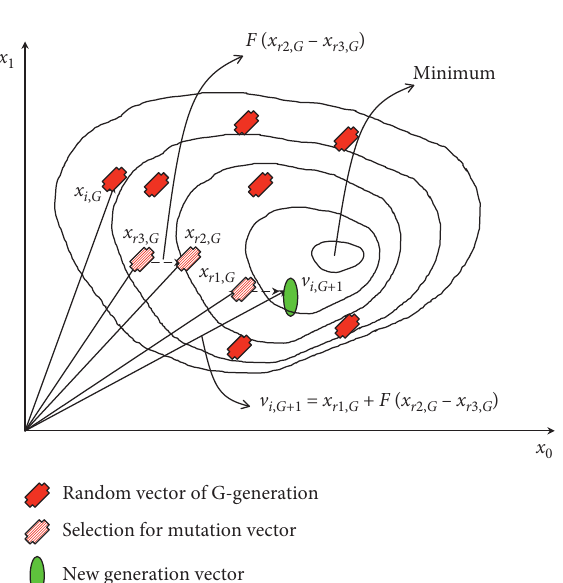
Figure 3: DEA process in two-dimensional space (Storn and Price